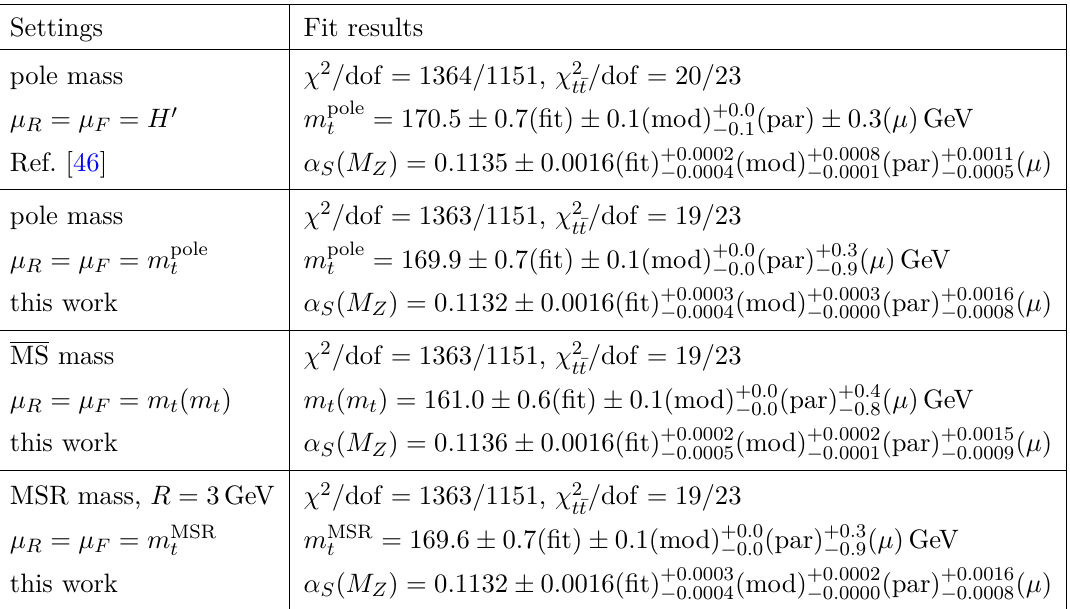
Table 3 . The values for α S ( M Z ) and the top-quark mass in different mass schemes obtained in ref. [46] and in this work by fitting the CMS data on t ¯ t production and the HERA DIS data [89] to theoretical predictions. The fit, model (mod), parametrisation (par) and scale variation ( µ ) uncertainties are reported. Also the values of χ 2 are reported, as well as the partial χ 2 values per number of degrees of freedom (dof) for the t ¯ t data ( χ 2 ) for 23 t ¯ t cross-section bins in the fit. The t ¯ t scale H 0 is defined in the